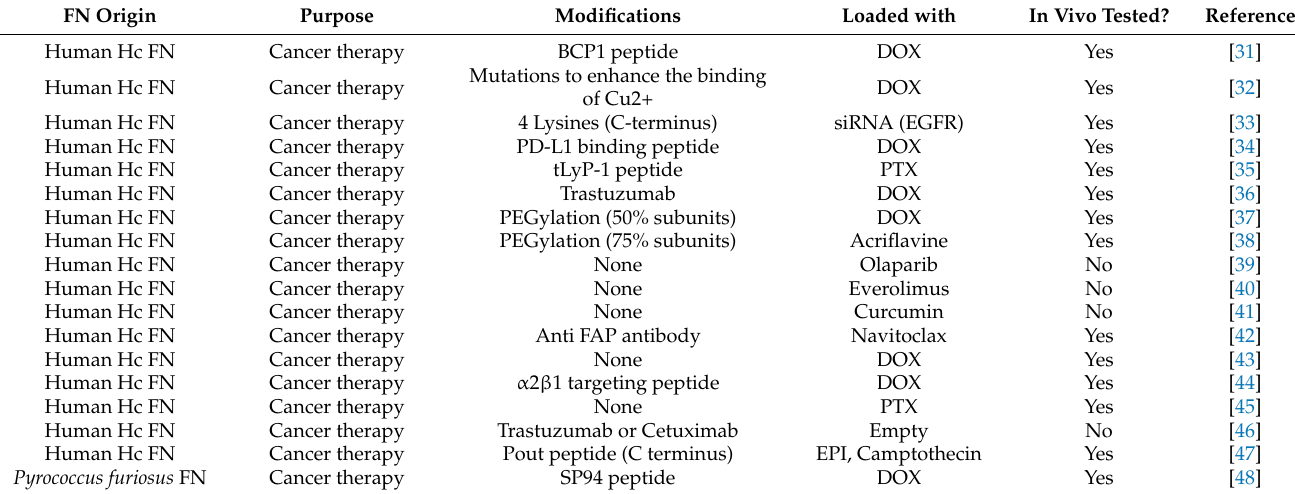
Table 1. FN-based NPs for the imaging and treatment of tumors.